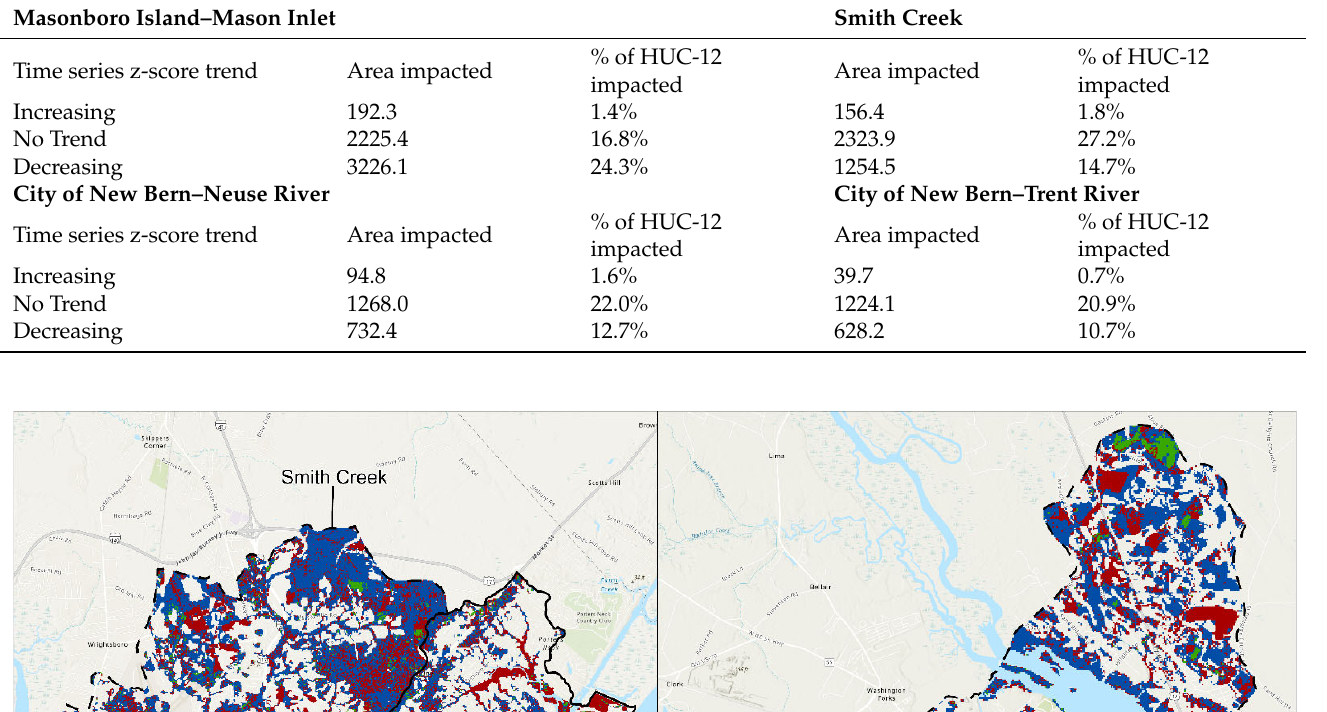
Table 3. Summary of the NDVI-based time series analysis z-score results for our four study areas in acres and as a percentage of the HUC-12 impacted.